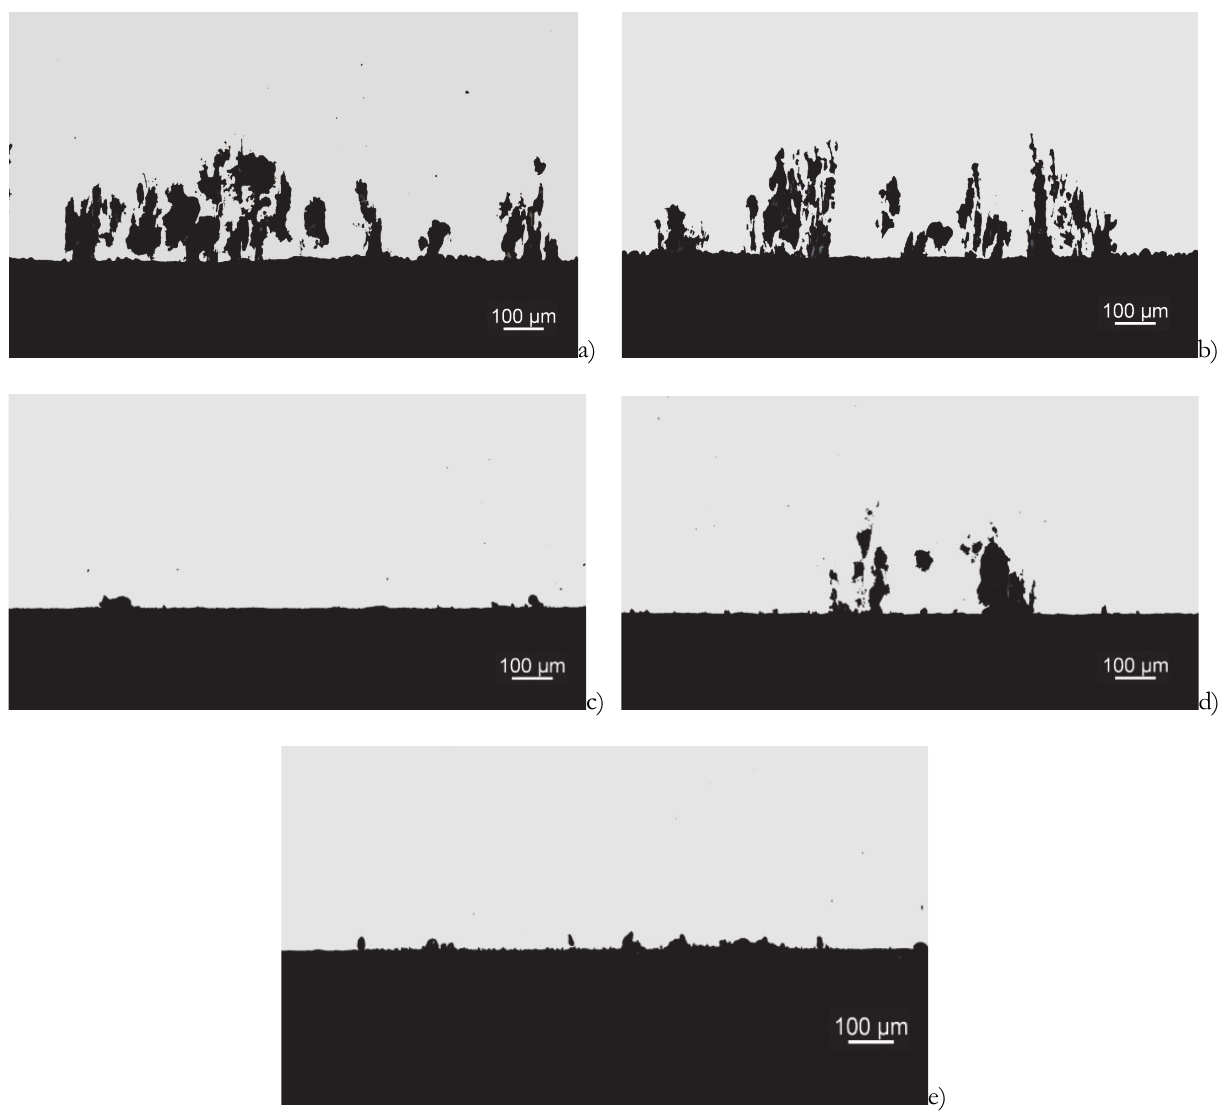
Figure 7: Results of intergranular corrosion tests in samples with different ageing parameters – a) 121°C, 24h; b) 140°C, 12h; c)140°C, 81h; d) 166°C, 3h; e)